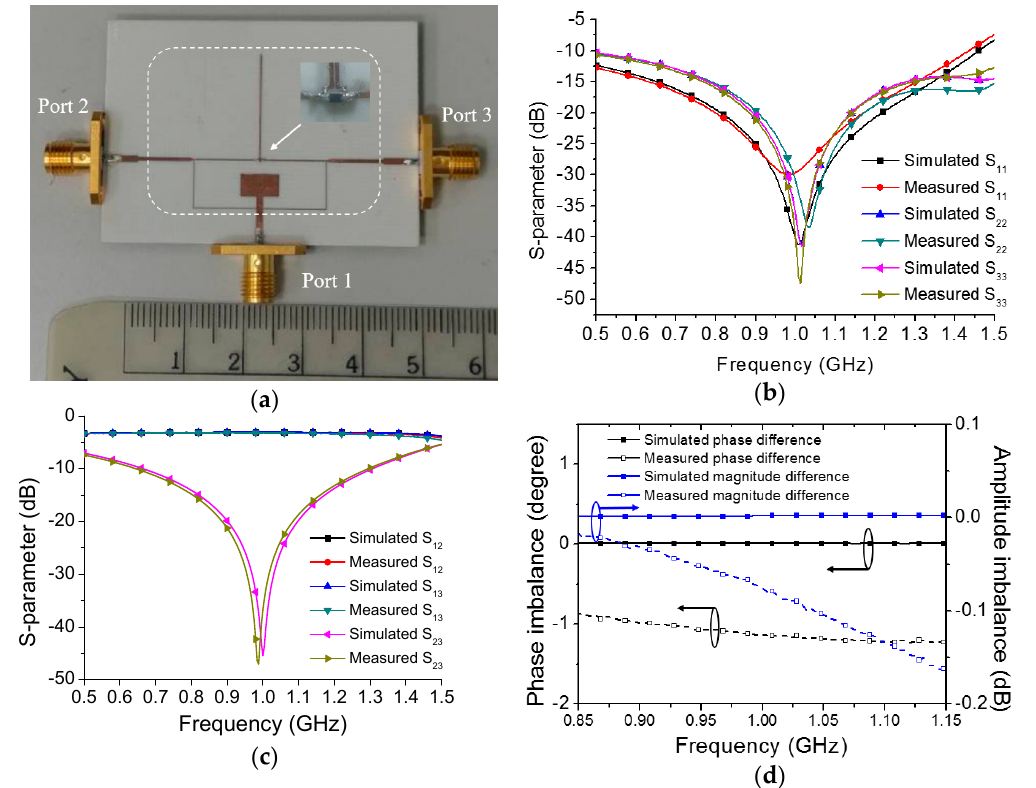
Figure 6. ( a ) The photo; ( b ) measured and simulated S 11 ,S 22 ,S 33 ; ( c ) measured and simulated S 12 ,S 13 ,S 23 ; ( d ) measured and simulated phase and amplitude imbalance of the fabricated prototype at 1 GHz.